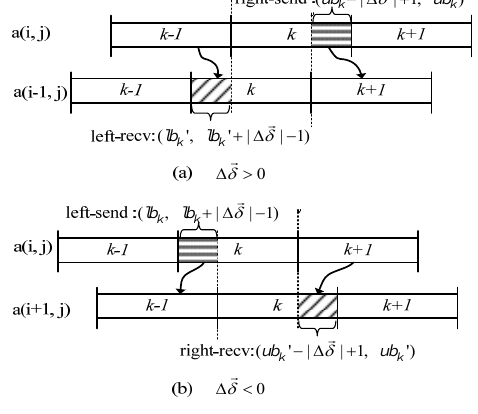
Figure 12. Nearest-neighbor